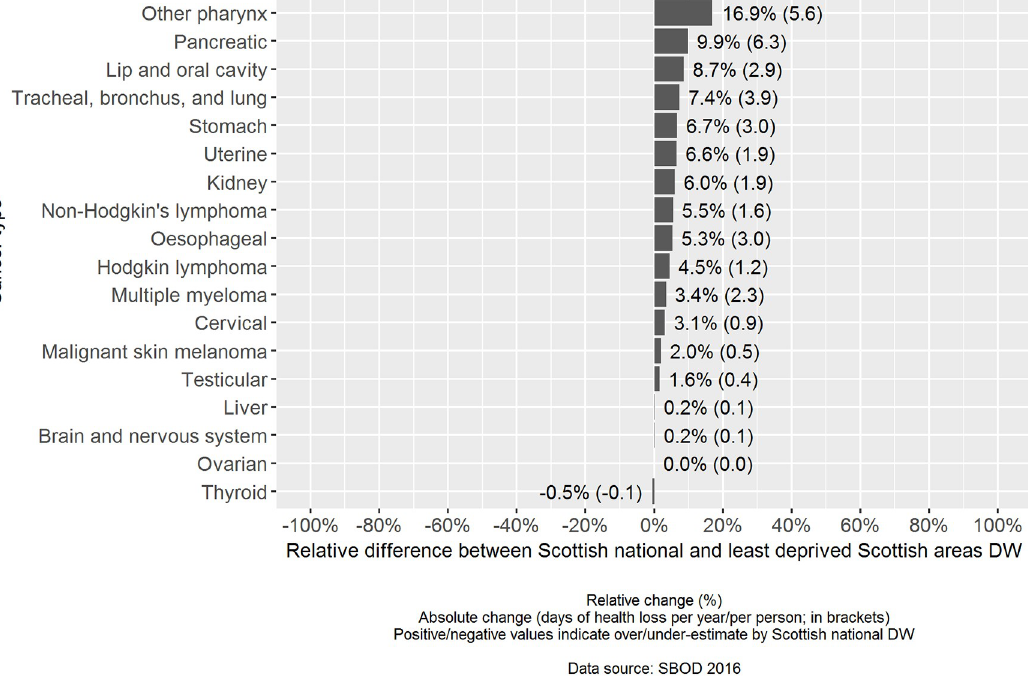
PLOS ONE | https://doi.org/10.1371/journal.pone.0221026 August 9,